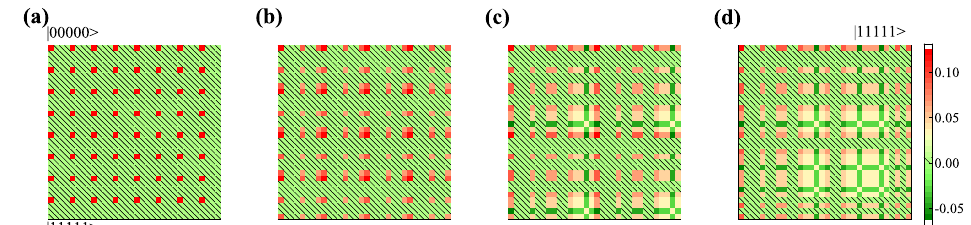
Figure 2. Density matrices for a series of quantum states during the processing ahead of QFT † . (The (cid:78) 3 | input state is | 0 (cid:105) 00 (cid:105) ). ( a ) The density matrix ρ 1 of φ 1 . ( b ) The density matrix ρ 2 of φ 2 . ( c ) The density matrix ρ 3 of φ 3 . ( d ) The density matrix ρ 4 of φ 4